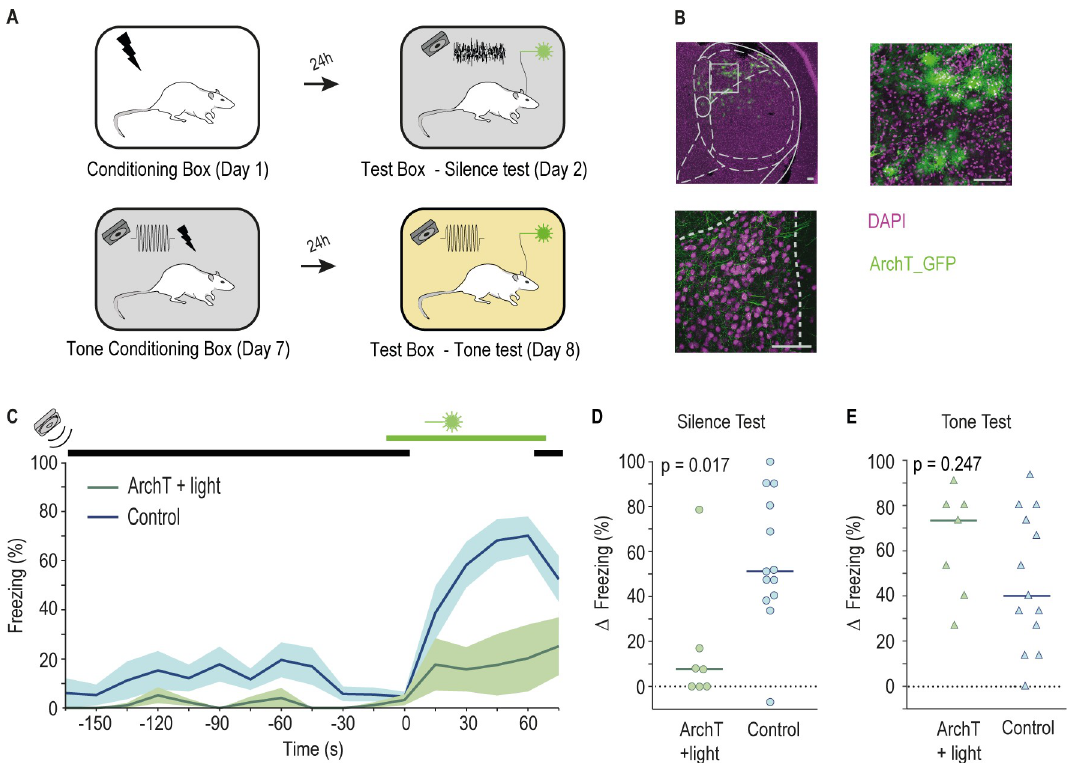
Fig 3. Activity in the MGD is necessary for freezing triggered by the cessation of movement-evoked sound but not by a conditioned tone cue. (A) Schematics of the behavioral paradigm used for testing the role of the MGD in freezing triggered by the cessation of movement-evoked sound and 5-kHz pure tone. (B) Top left, coronal brain section from a representative rat, in which MGD neurons express ArchT; top right, image with a higher magnification of the area highlighted by the white square on the left image (see S1 Movie for detailed anatomy). Bottom, axon terminals in the tip of LA originating from ArchT-expressing cells in MGD. Pink, cell bodies labeled with DAPI. Green, cell bodies and cellular processes of cells expressing ArchT-GFP. Scale bar 100 μ m. (C and D) Same as Fig 1C and 1D (respectively) for rats expressing ArchT and exposed to light illumination in the MGD (green, n = 7) and respective controls (blue, n = 13 including animals from both Ct light and Ct ArchT groups). Horizontal bar represents the median value (ArchT + light = 7.73%, Control = 51.20%, Wilcoxon rank sum test, rank sum = 43) (S1 Data, Sheet Fig 3). (E) Individual value plot displaying the change in the percentage of time animals spent freezing during the 15 seconds immediately preceding the presentation of the 5-kHz conditioned tone and the 15 seconds during which the tone was played. Horizontal bar represents the median value (ArchT + light = 73.33%; Control = 40.00%; Wilcoxon rank sum test, rank sum = 88.5) (S1 Data, Sheet Fig 3). ArchT, archaerhodopsin from Halorubrum strain TP009; Ct ArchT, control ArchT; Ct light, control light; LA, lateral amygdala; MGB, medial geniculate body; MGD, dorsal division of the MGB; DAPI, 4’, 6-diamidino-2-phenylindole; GFP, green fluorescent protein.